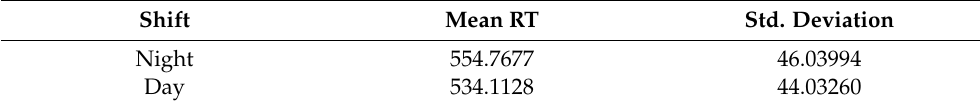
Table 5. Descriptive results of the RTs (dependent variable: mean RT).